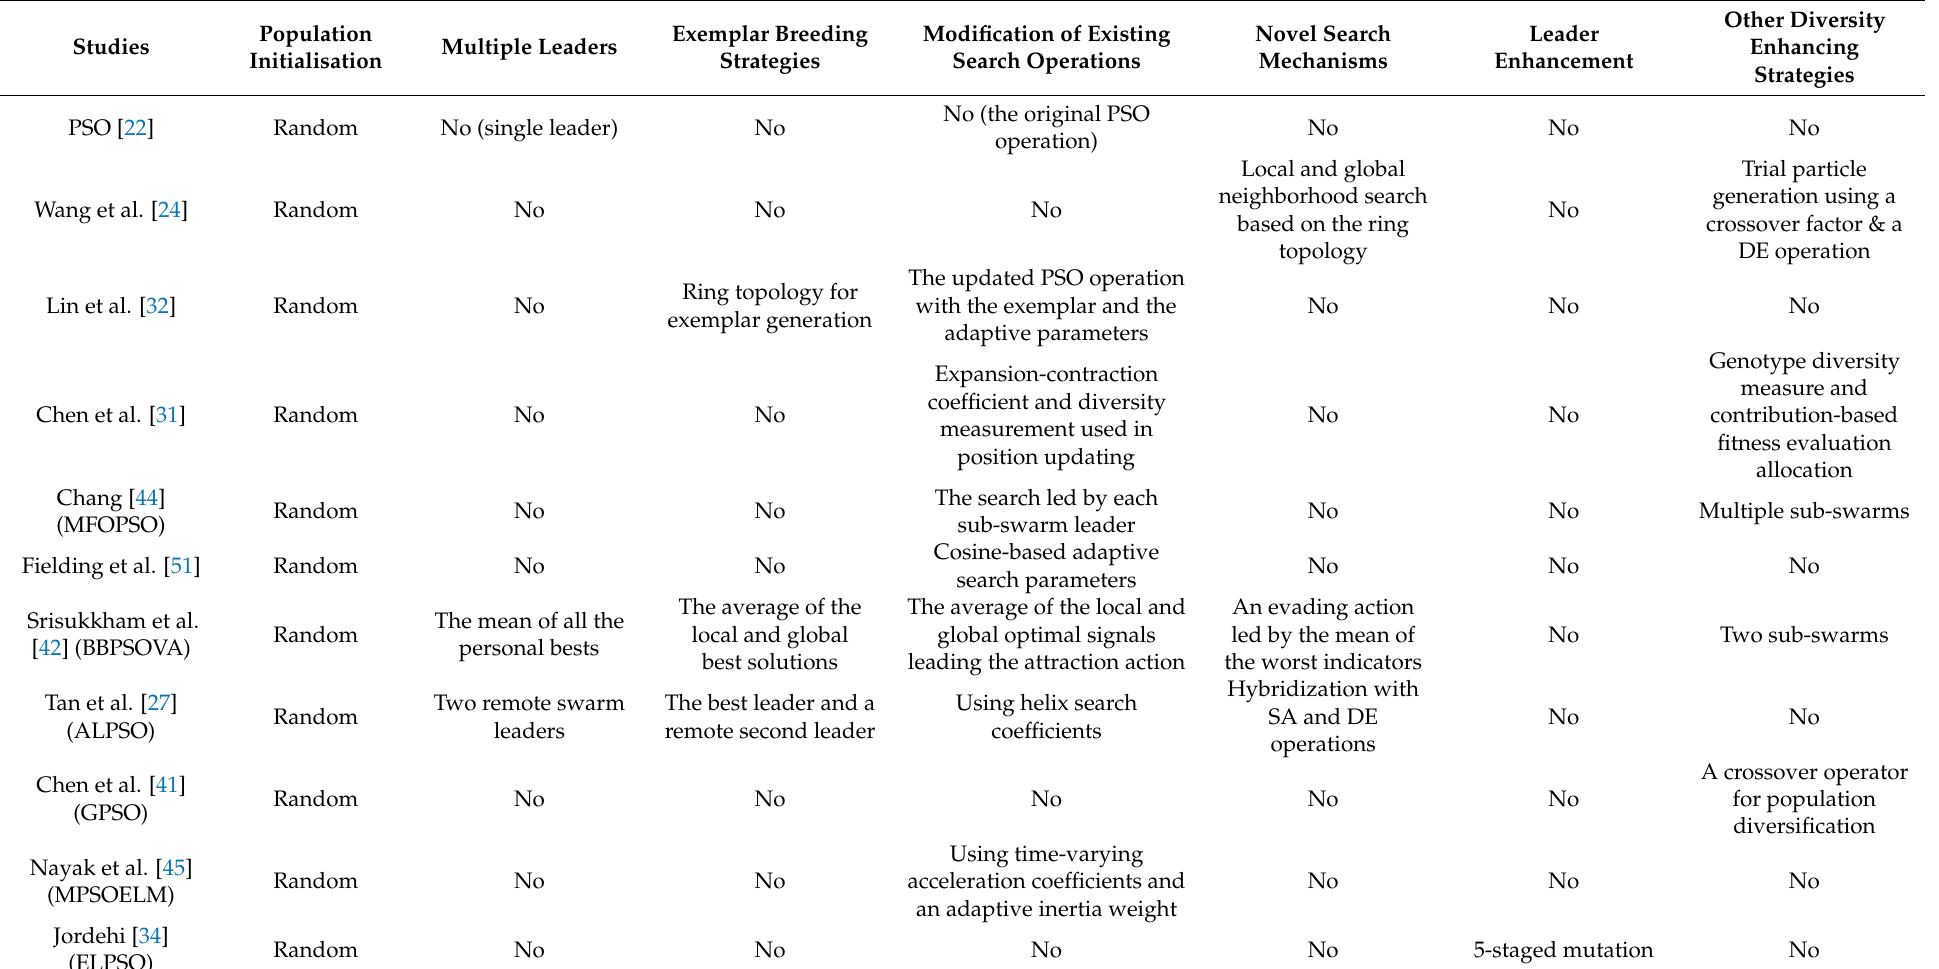
Table 1. Comparison between existing studies and this